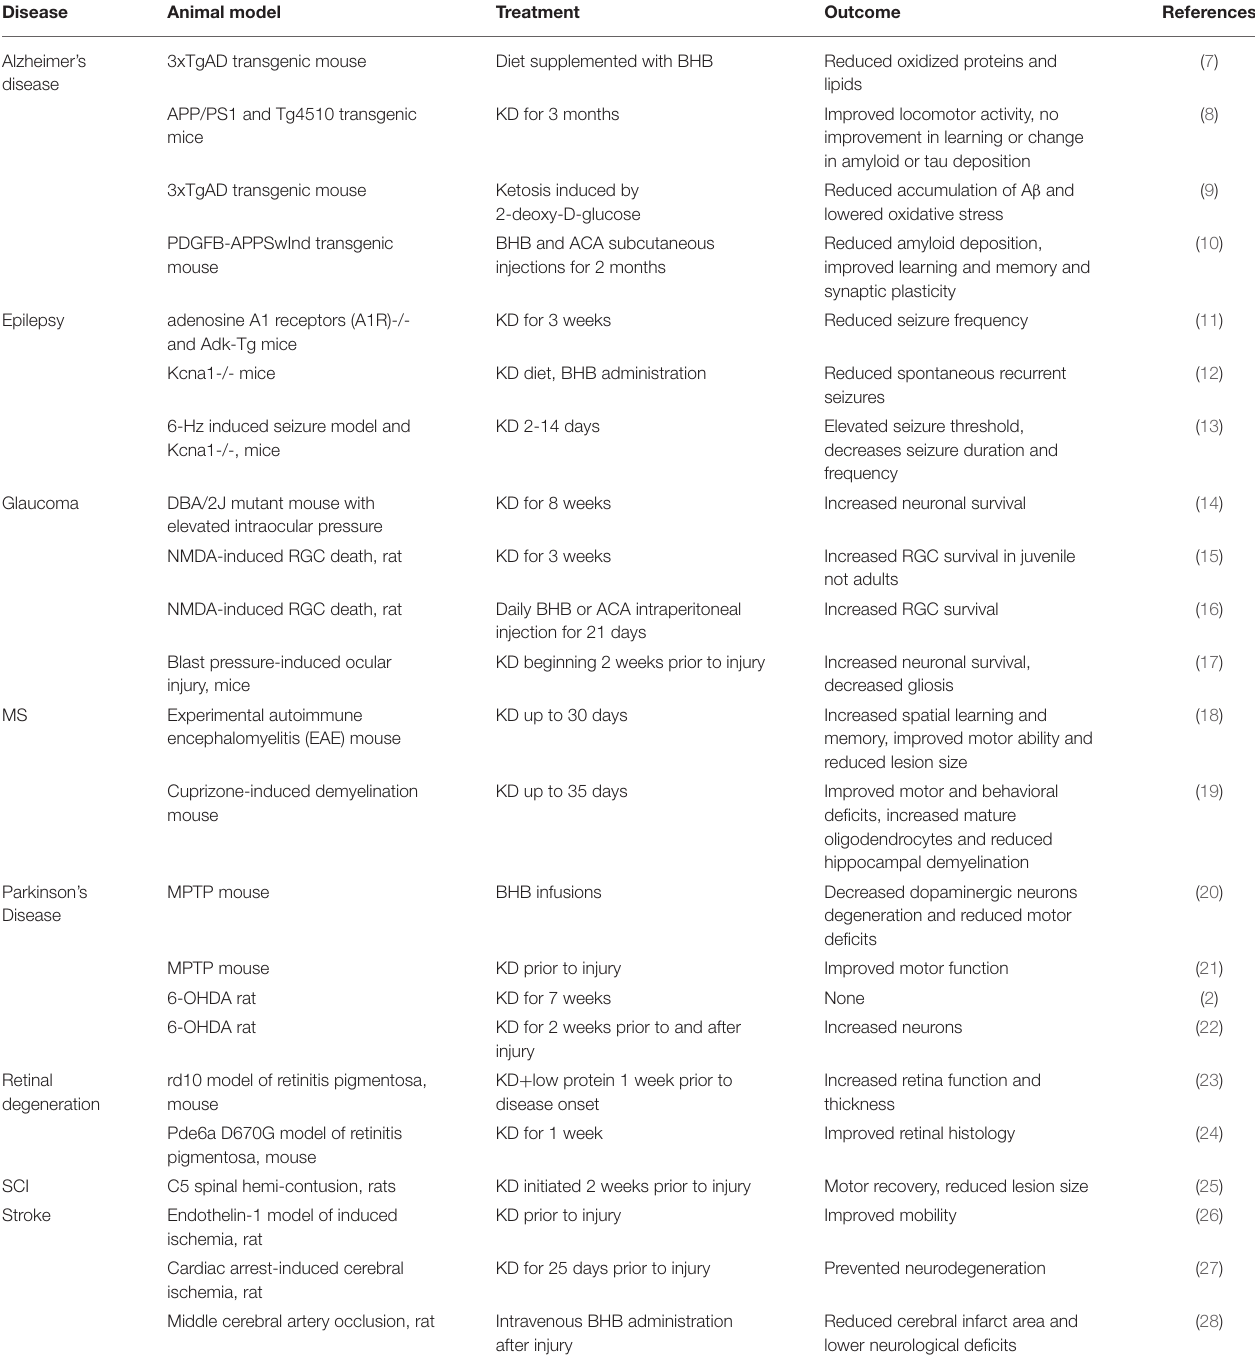
TABLE 1 | Beneficial effects of the KD or ketone bodies in animal models.